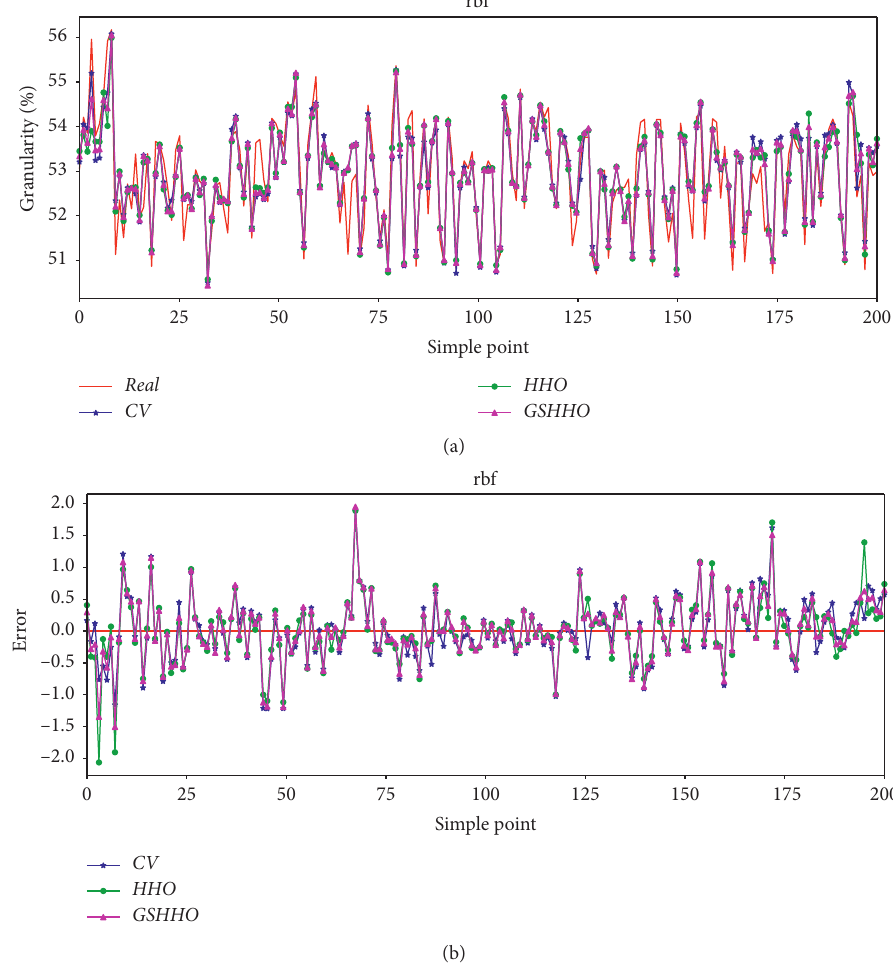
Figure 9: Prediction results under LSSVM model with rbf function. (a) Prediction results under different LSSVM models. (b) Prediction errors under different LSSVM